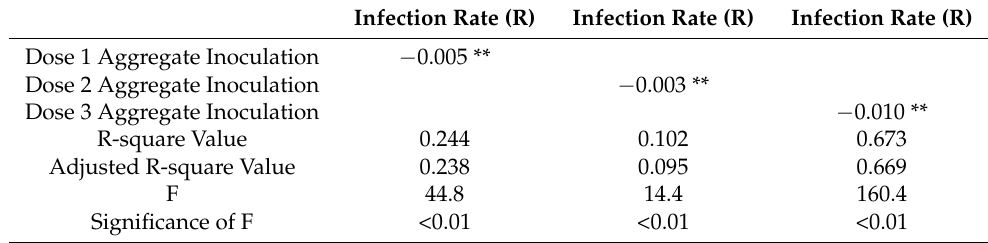
Table 12. Regression been the daily infection rates (R) and doses 1, 2, and 3.